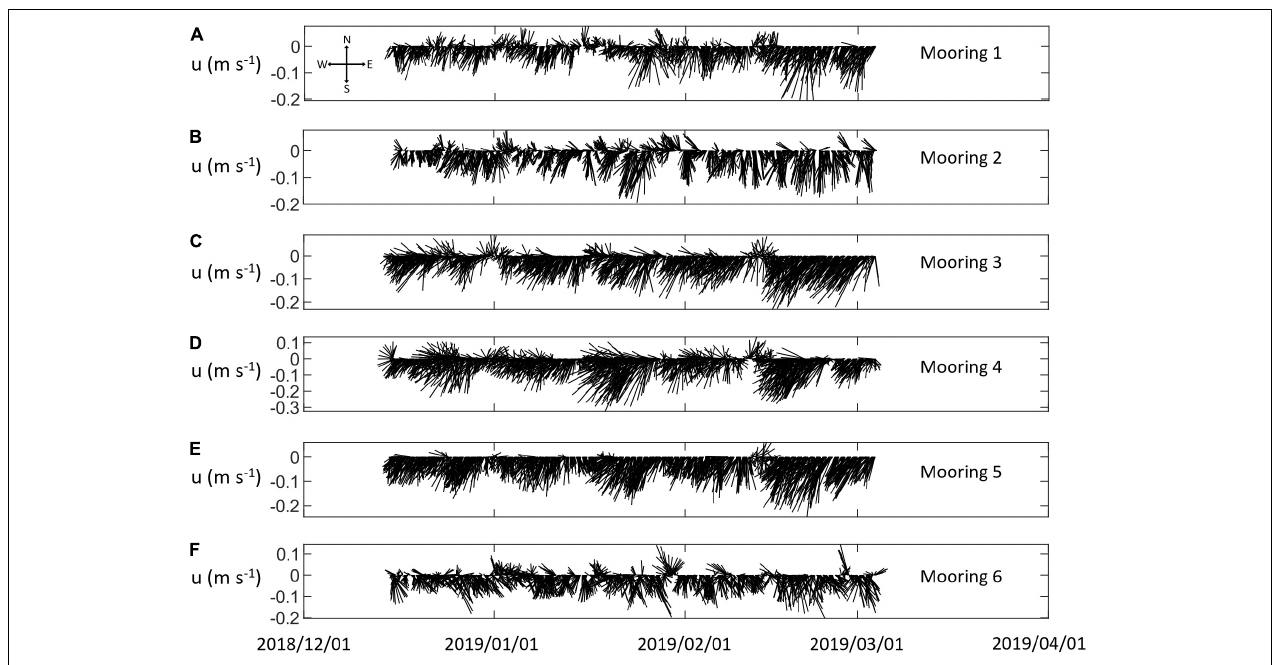
FIGURE 8 | Hourly mean water flow velocity vectors, u (m · s − 1 ) over the integration depth range, by Mooring and date (year/month/day). (A–F) Correspond to Moorings 1–6.